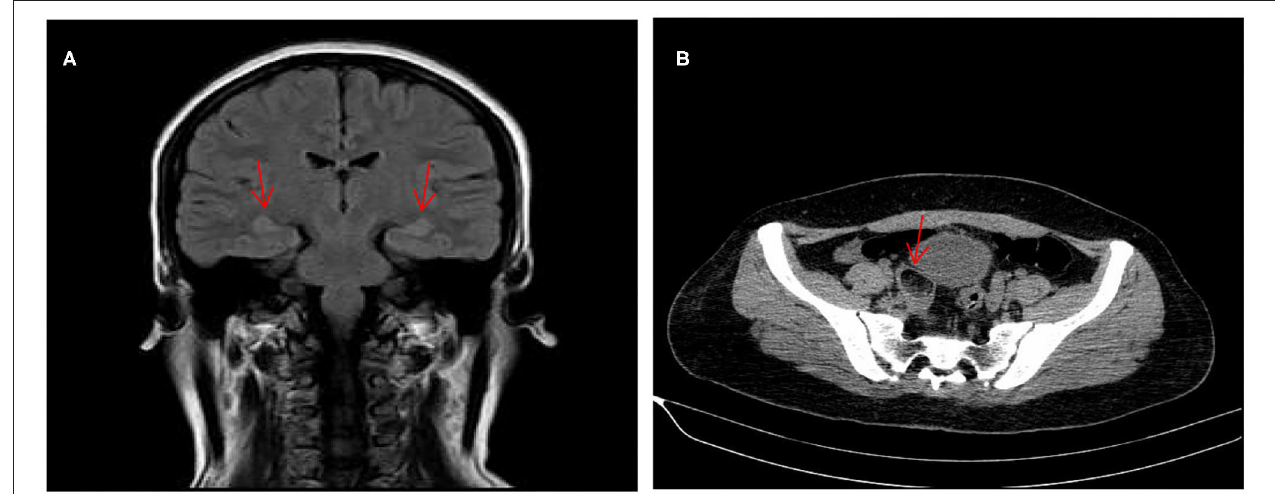
FIGURE 1 | MRI of the brain revealed subtle increased signal intensity in bilateral hippocampal on FLAIR sequences (A) . CT scan of the abdomen indicated a space-occupying lesion in right-side ovarian, later pathologically identified as mature ovarian cystic teratoma (B)